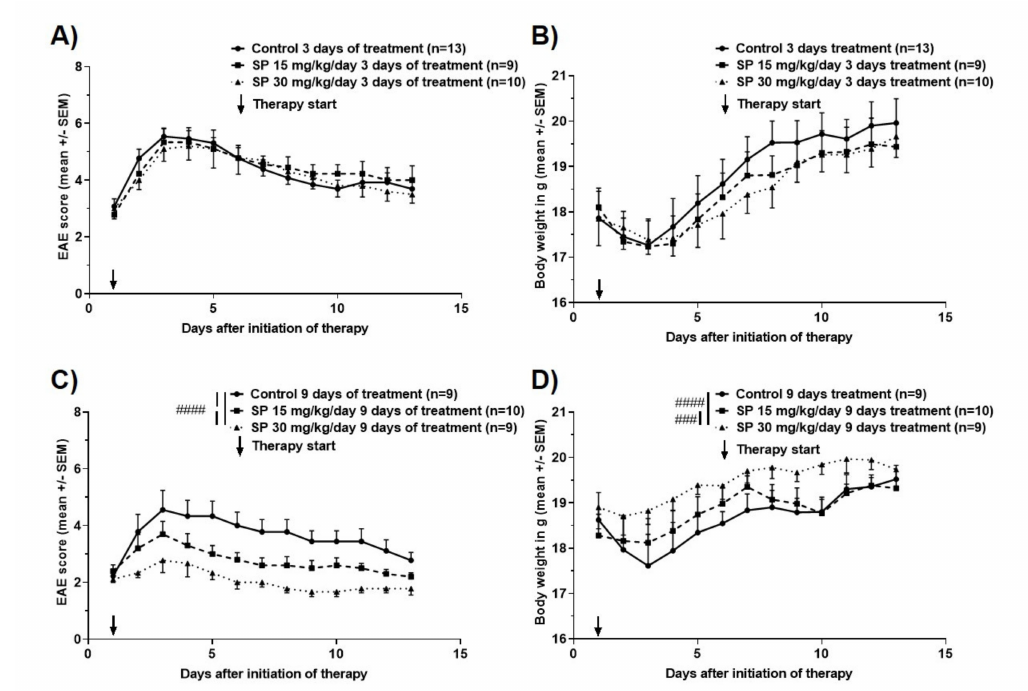
Figure 2. Clinical disease course of MOG 35-55 EAE in C57BL / 6JRj wild type mice treated for ( A ) three or ( C ) nine consecutive days with control (dimethyl sulfoxide (DMSO (in peanut oil), SP600125 15 or 30 mg / kg / day. Body weight during course of MOG 35-55 EAE in C57BL / 6JRj wild type mice treated for ( B ) three or ( D ) nine consecutive days with control (DMSO in peanut oil), SP600125 15 or 30 mg / kg / day. Numbers of included animals are displayed in the graph. EAE score: 10 score system according to [18]. Abbreviations: EAE: Experimental autoimmune encephalomyelitis, SEM: Standard error of the mean